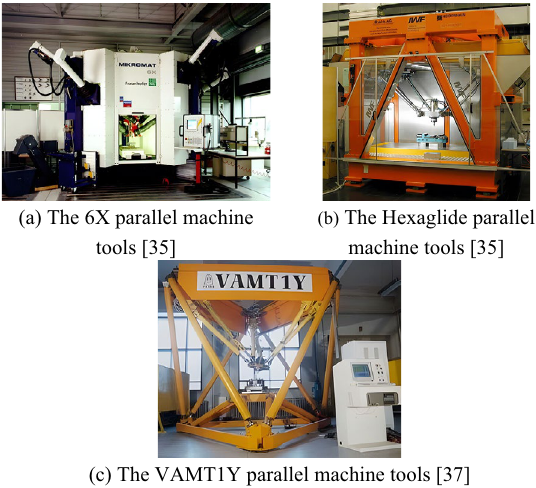
Figure 9 Parallel machine tools developed by institutions: a The 6X parallel machine tools [35]; b The Hexaglide parallel machine tools [35]; c The VAMT1Y parallel machine tools